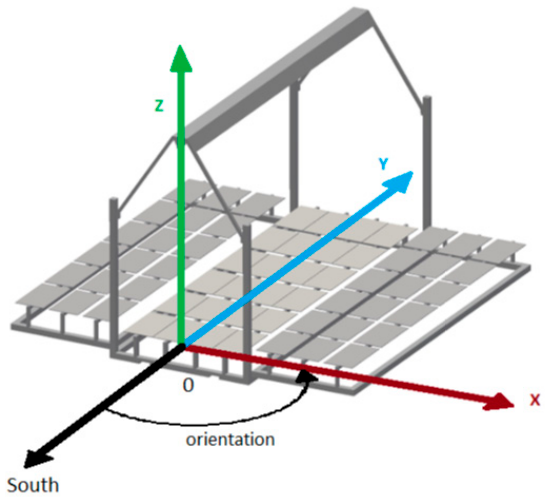
Figure 7. Axis defined for Fresnel module.